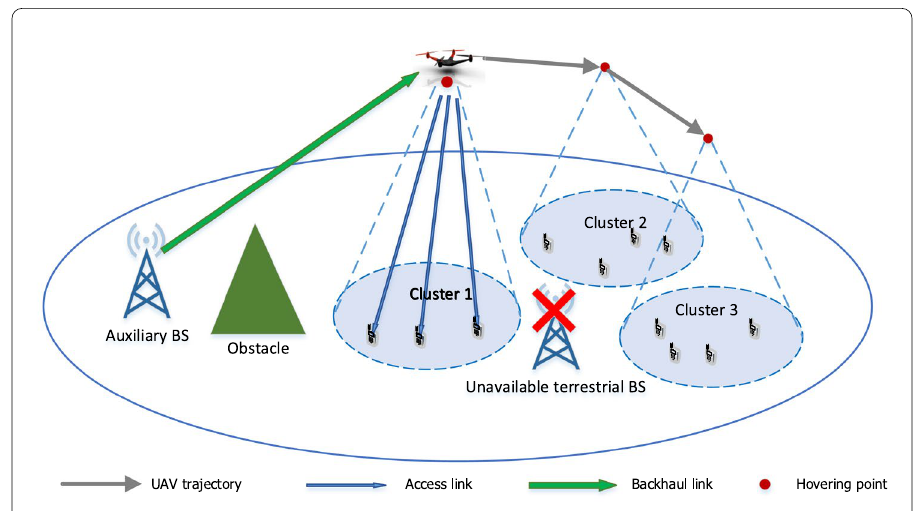
Fig. 1 A UAV network with N = 3